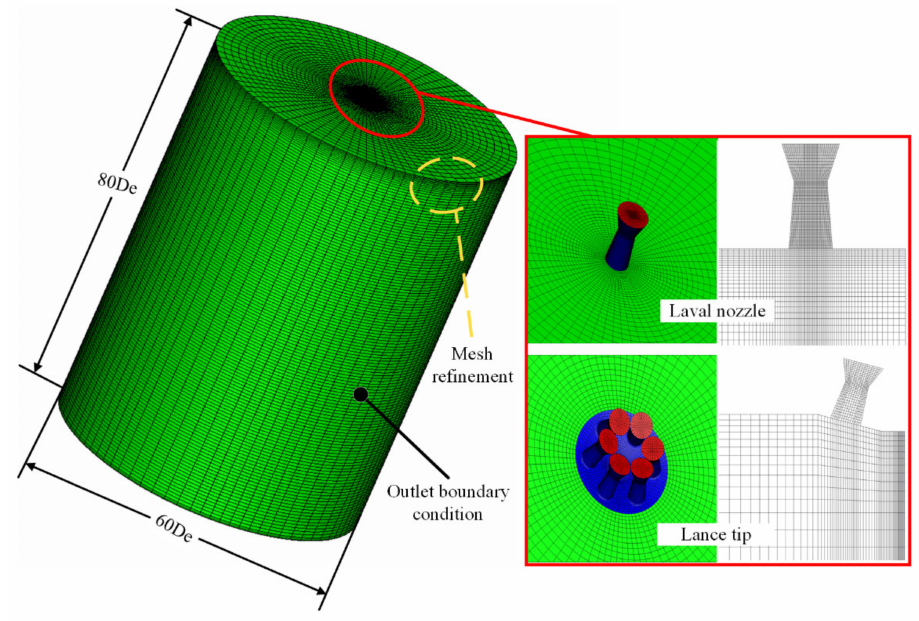
Figure 3. Detailed grid arrangement of the computational fluid dynamics (CFD)